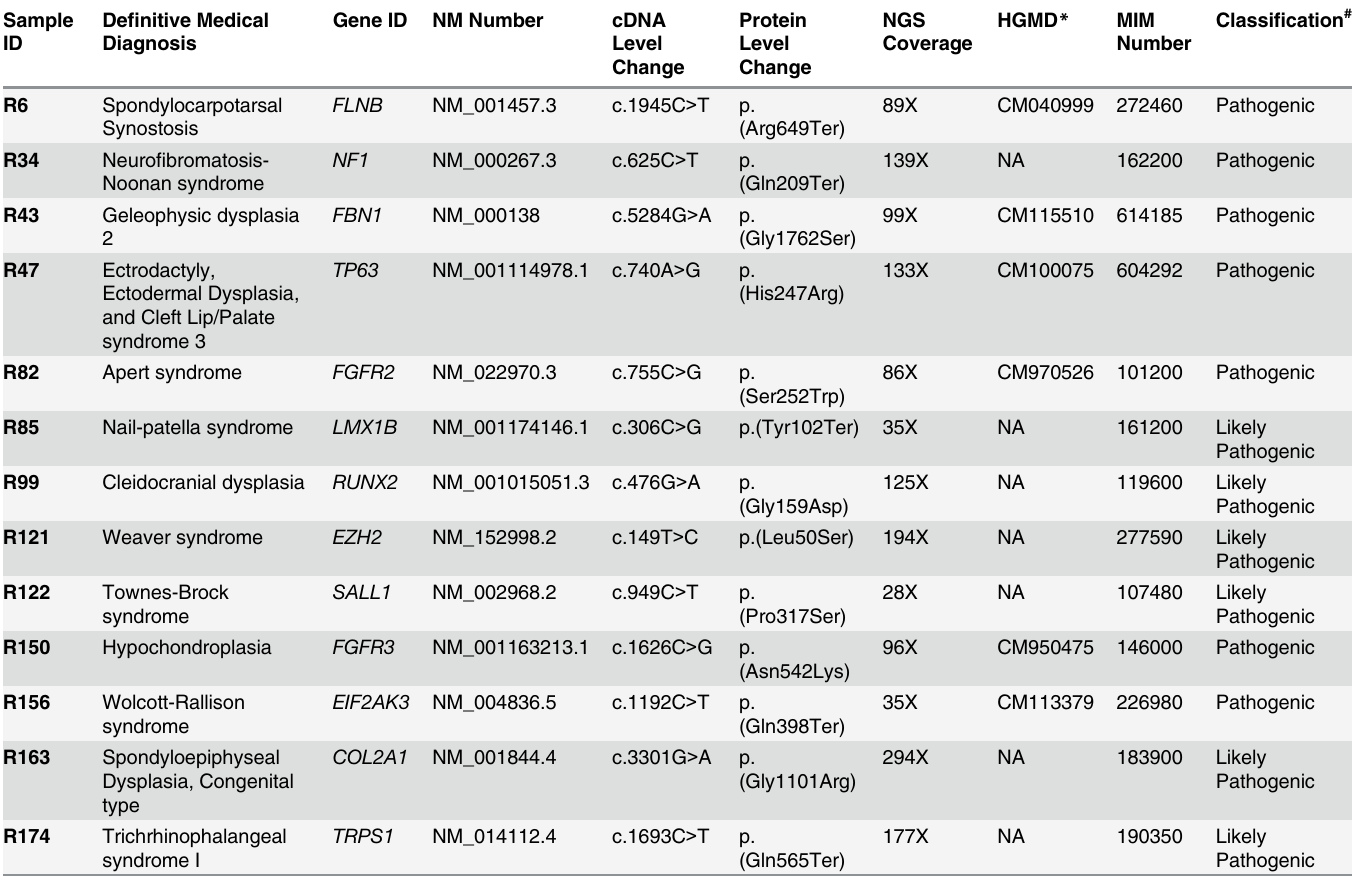
Table 1. Summary of causative mutations identified after molecular analysis in the investigated cases. Sample